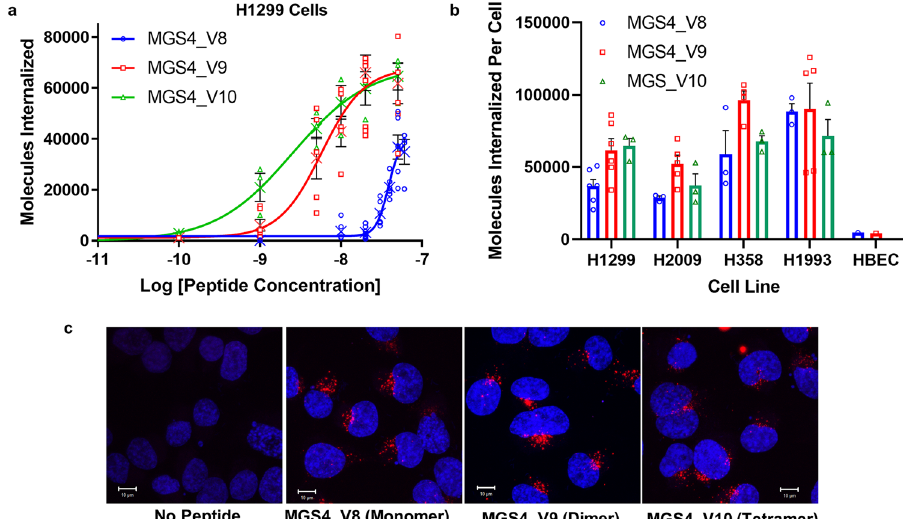
Fig. 2 Increased valency of truncated MGS4_V8 decreases EC50 but does not impact absolute update of the peptide or subcellular location. a MGS4_V8, MGS4_V9, or MGS4_V10 were conjugated with streptavidin-Alexa Fluor 647 and H1299 cells were incubated with the labeled conjugate for 1 h. Non-internalized peptide was removed, and the mean number of peptides internalized per cell was determined to calculate the EC50. Individual measurements are shown. The mean is shown as an “ X ” . Error bars, in black, represent standard error measurements and are below the height of the symbols in some cases. b The average number of peptide molecules per cell at 50 nM at 1 h was determined on four NSCLC cell lines and one normal human bronchial epithelial cell line (HBEC). Error bars represent SEM and individual data points are shown. c H1299 cells were incubated with 50 nM peptide-Streptavidin-Qdot605 for 1 h, removed, and replaced with normal growth media. After 24 h, cells were fi xed, and counterstained with DAPI (blue). Representative maximally projected z-stacks for each group reveal no apparent difference in peptide internalization or localization. The scale bar represents 10 µ